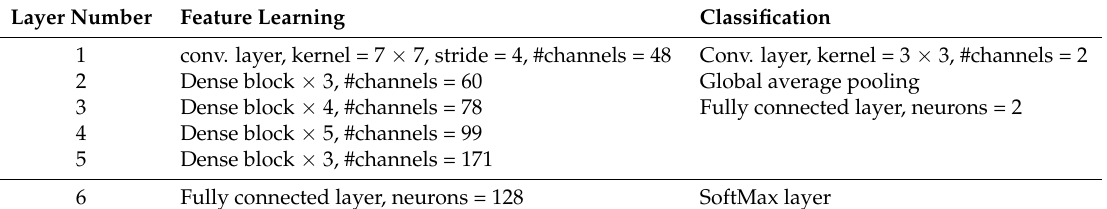
Table 2. Structure Parameters of the Proposed Common Fake Feature Network for Fake General Image